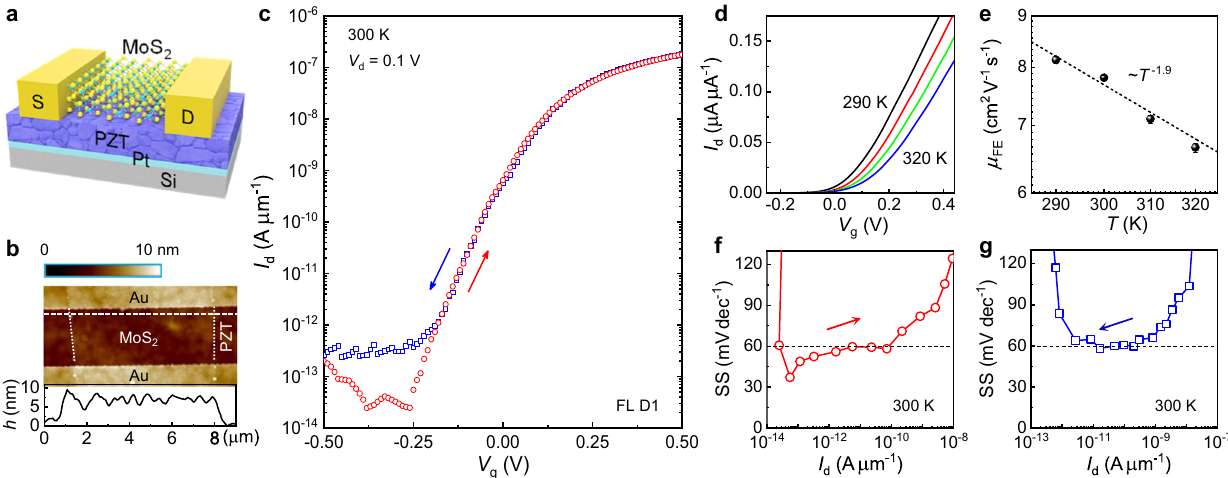
Fig. 2 Characterization of a few-layer MoS 2 FET. a Device schematic. b AFM topography image of a few-layer MoS 2 device (FL D1) with the height pro fi le along the dashed line (lower panel). The dotted lines outline the MoS 2 fl ake. c Transfer characteristics of the MoS 2 FET at 300 K in both forward and reverse V g -sweeps at scan rate of 10 mV s − 1 . d Transfer characteristics of the device at various temperatures (top to bottom: 290, 300, 310, and 320 K), and e the corresponding μ FE vs . T with a fi t to T (cid:5) 1 : 9 . f , g Point - by-point SS vs . I d extracted from panel c in f forward V g -sweep and g reverse V g -sweep. The dashed lines depict the thermal limit for SS at 300 ¼ 7 : 8 cm 2 V (cid:5) 1 s (cid:5) 1 , comparable with channel length. At 300 K, μ FE